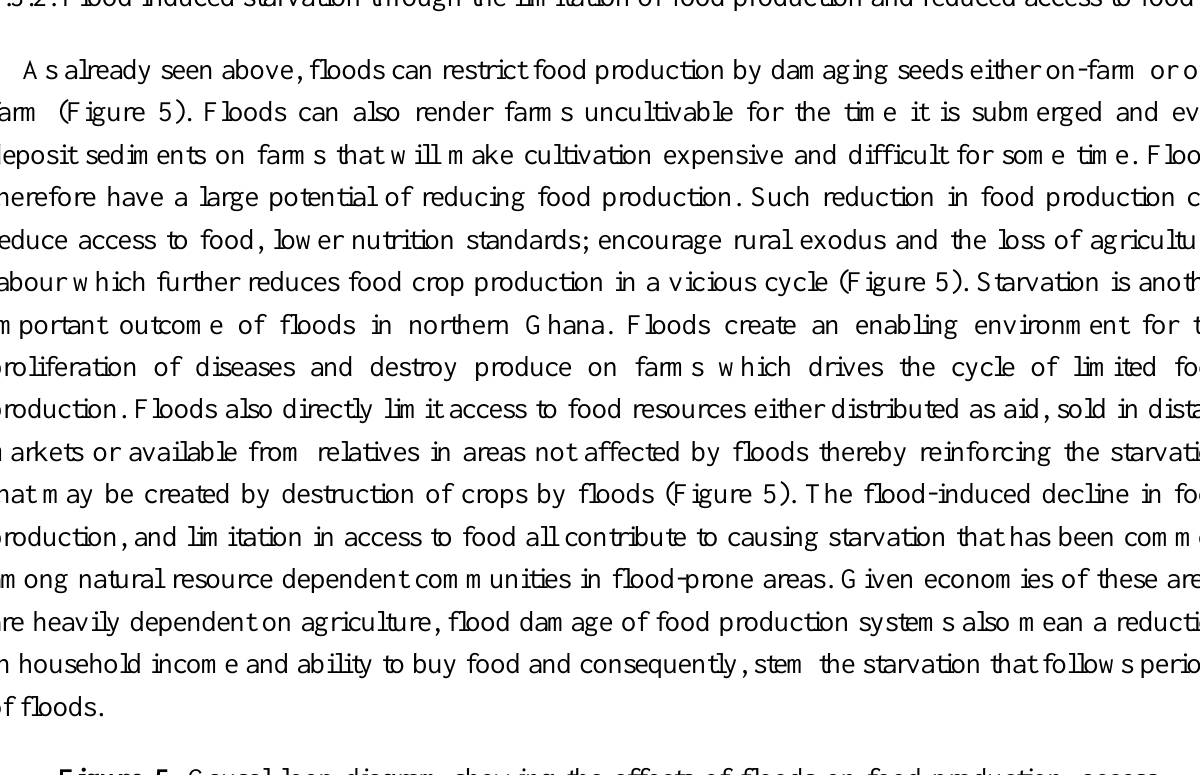
Figure 5. Causal loop diagram showing the effects of floods on food production, access and causation of